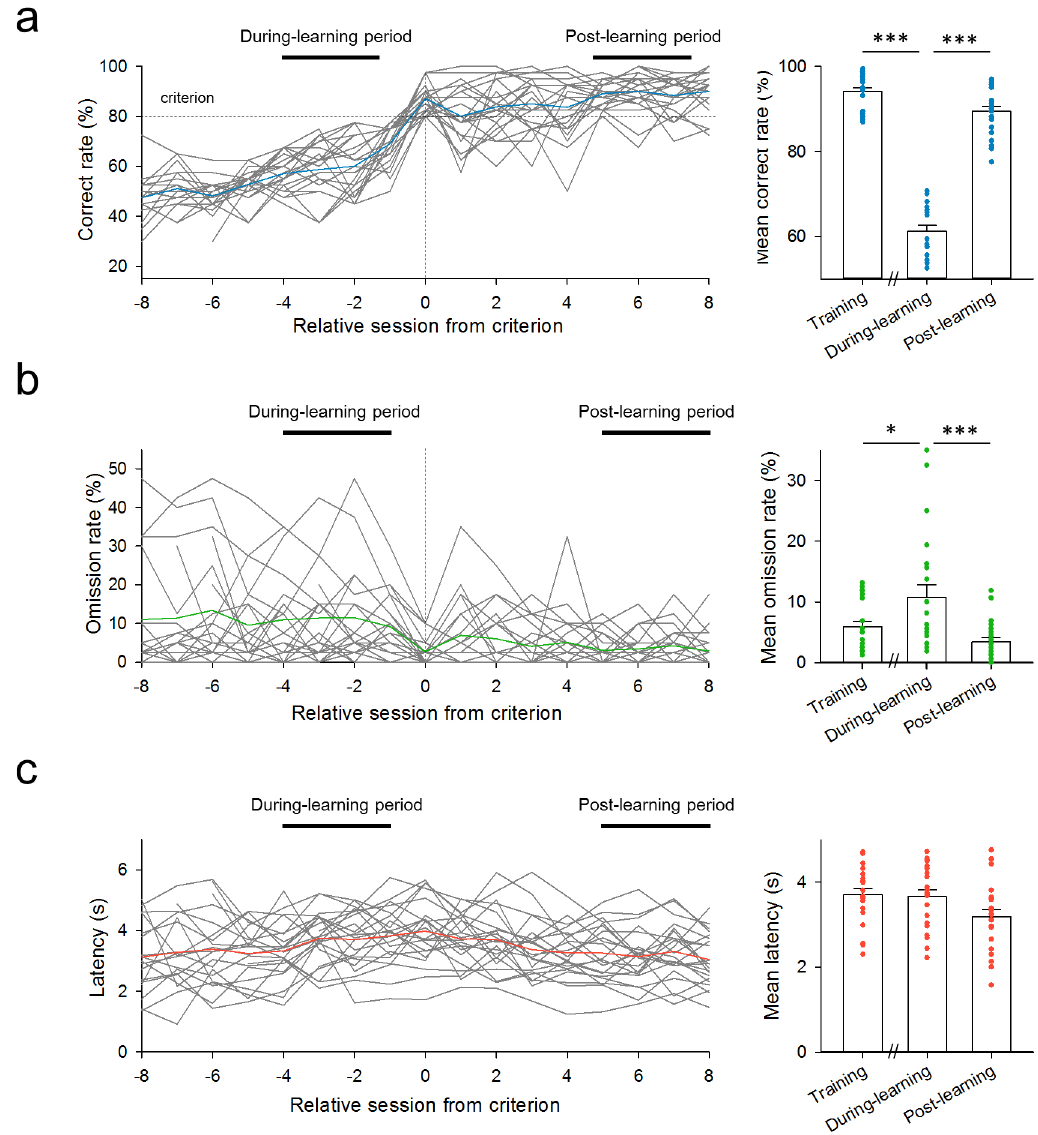
Fig 4. Behavioral parameters before, during, and after learning. (a) Left : time changes in the correct rates for 22 individual rats (gray) were aligned to the first session that reached the criterion. The blue line indicates the mean value. Right : training represents data from the last 4 sessions on Day 2 in the training phase. Four sessions immediately before and 5-to-8 sessions after reaching the criterion were defined as the during-learning and post-learning periods, respectively. These periods are shown by the black bars in the left panel. The mean correct rate in the during-learning period was significantly lower than the mean correct rates in the training period and the post-learning period. Training versus during-learning: P = 9.56 × 10 −10 , Q 3,63 = 28.0; during-learning versus post-learning: P = 9.56 × 10 −10 , Q 3,63 = 24.0; P = 1.14 × 10 −29 , F 2,63 = 230; Tukey’s test after one-way ANOVA. (b) Same as a, but for the rates of omission trials. Training versus during-learning: P = 0.034, Q 3,63 = 3.62; during- learning versus post-learning: P = 6.91 × 10 −4 , Q 3,63 = 5.51; P = 9.12 × 10 −4 , F 2,63 = 7.84. (c) Same as a, but for the latencies to respond. Training versus during-learning: P = 0.984, Q 3,63 = 0.235; during-learning versus post-learning: P = 0.092, Q 3,63 = 3.01; P = 0.044, F 2,63 =